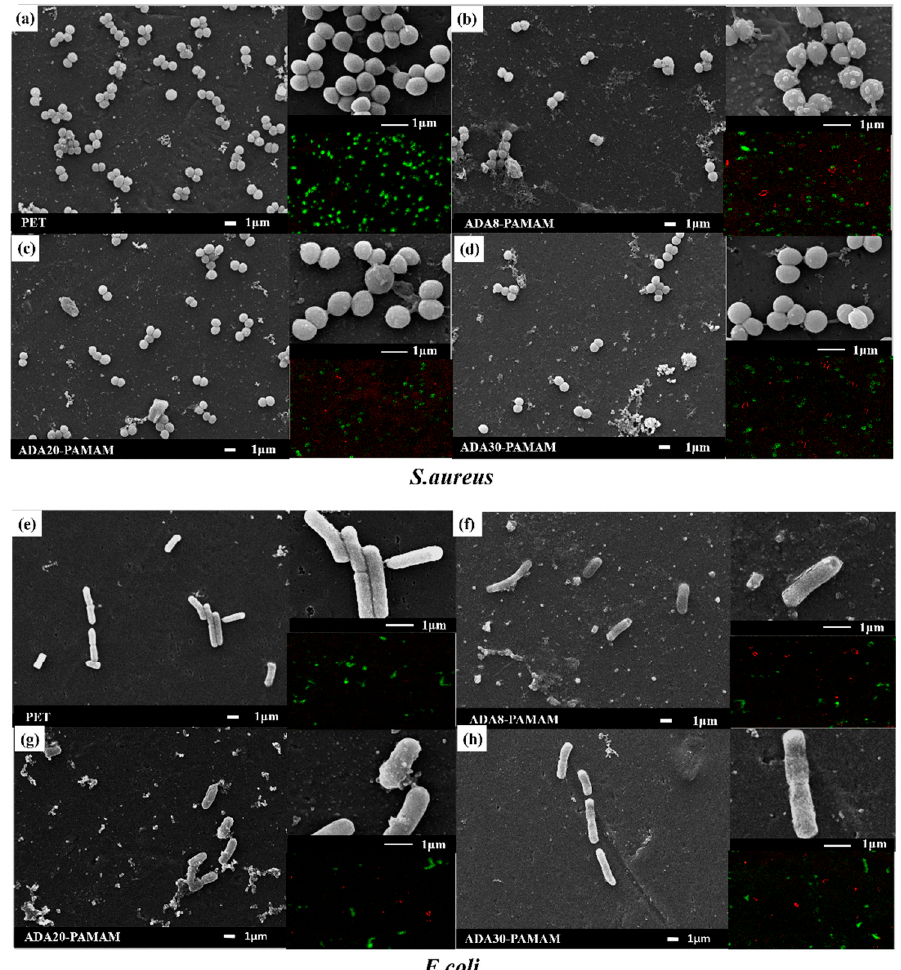
Figure 7. SEM and CLSM images of PET films after incubation, referring to S. aureus ( a – d ) and E. coli ( e – h ), respectively. For S. aureus , ( a ) refers to the observation of PET film, and ( b – d ) refer to the observation from ADA8-PAMAM, ADA20-PAMAM and ADA30-PAMAM, respectively. For E. coli ., ( e ) refers to the observation of PET film, and ( f – h ) refer to the observation from ADA8-PAMAM, ADA20-PAMAM and ADA30-PAMAM, respectively. Green and red dots in CLSM images refer to living and dead bacteria, respectively.